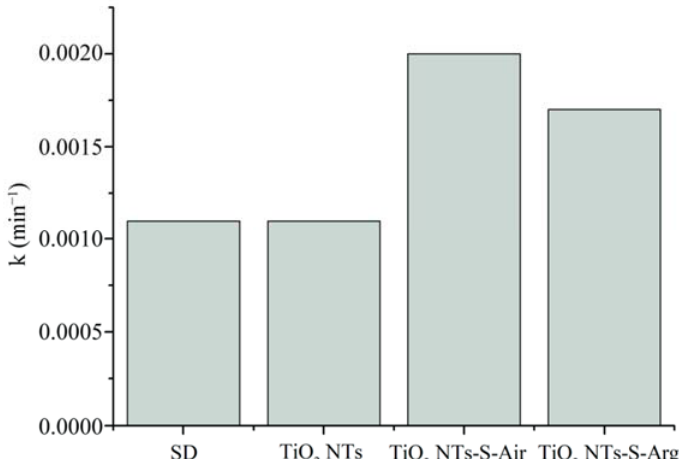
Figure 8. Rate constants of the decomposition reaction of methylene blue molecules using the obtained catalysts and without a catalyst (SD).